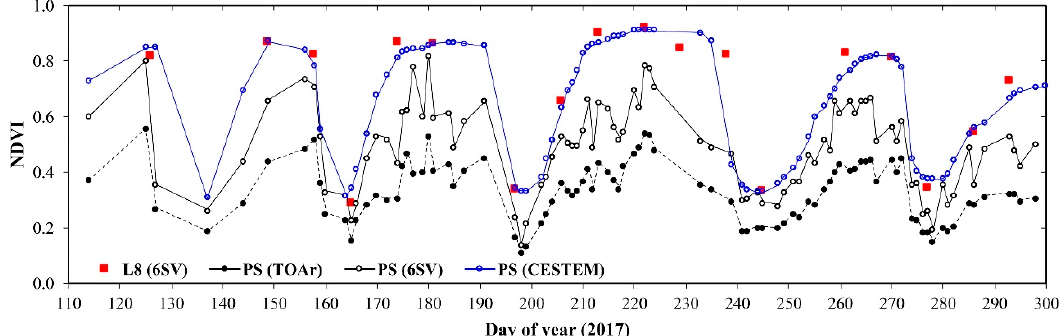
Figure 9. Temporal plot of Normalized Difference Vegetation Index (NDVI) measurements of alfalfa in Saudi Arabia. Measurements by Planet Doves (black circles) show poor calibration but rich temporal density. Combining these measurements with Landsat 8 (red squares) through CESTEM provides an accurate and spatially dense NDVI estimate (blue line).